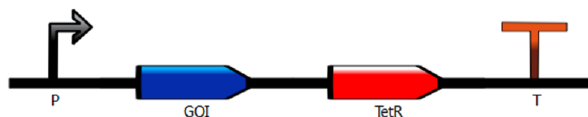
Figure 4. In our simulation experiments, when a bacterium satisfies a condition, it is equivalent in synthetic biology to a bacterium carrying a gene of interest (GOI). This means that the protein it synthesizes is useful in industry, clinics, etc. When GOI is expressed by synthesizing a protein, then the antibiotic resistance gene is also expressed, for example, tetracycline resistance (TetR). As a result, bacteria that do not meet the condition will not express the resistance gene and will die in the presence of the antibiotic. The genome of the bacterium shows the promoter (P) and terminator (T).